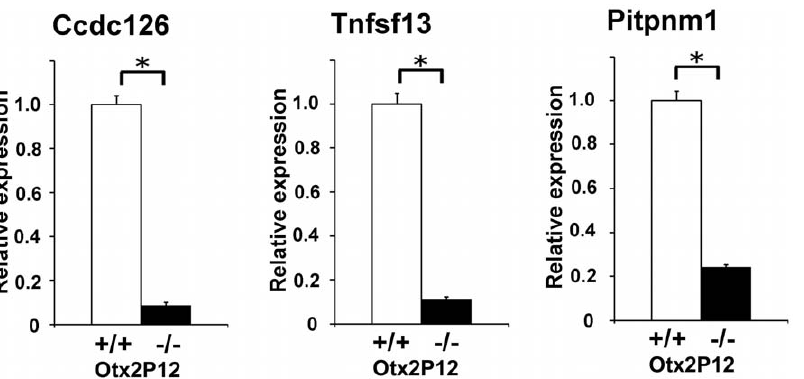
Figure 6. Expression of identified candidate genes for human retinal diseases in the Otx2 CKO retina. Expression of identified candidate genes for human retinal diseases was analyzed by Q-PCR. Expression levels of selected genes were normalized to the expression levels of a housekeeping gene, Gapdh . The mean of the value of control at P12 was set as 1.0. Error bars show the SD (n = 3). *, P , 0.03.